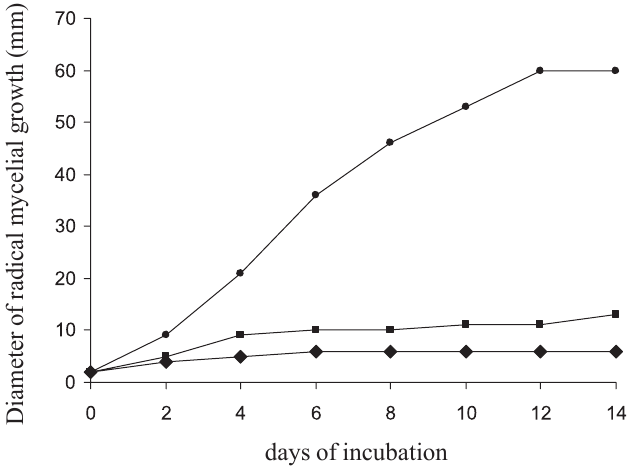
FIGURE 3 - Radial mycelia growth for M. canis LM-36 as a function of the antifungal compound: (-): control (0 µL/mL); (  ): O. vulgare essential oil (80 µL/mL); (  ): ketoconazole (50